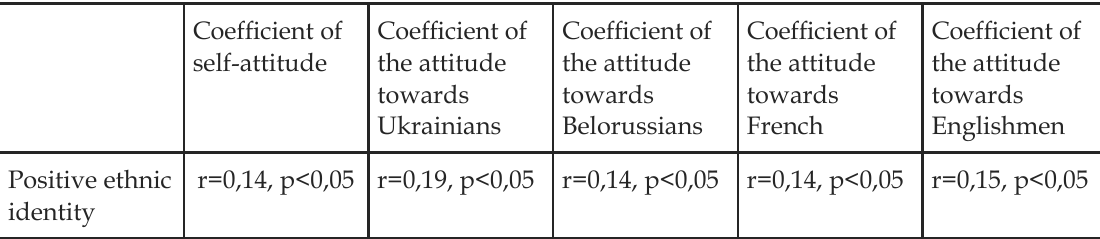
Tab. 2. The correlation of a positive ethnic identity with the scales of diagnostic attitudes tests.